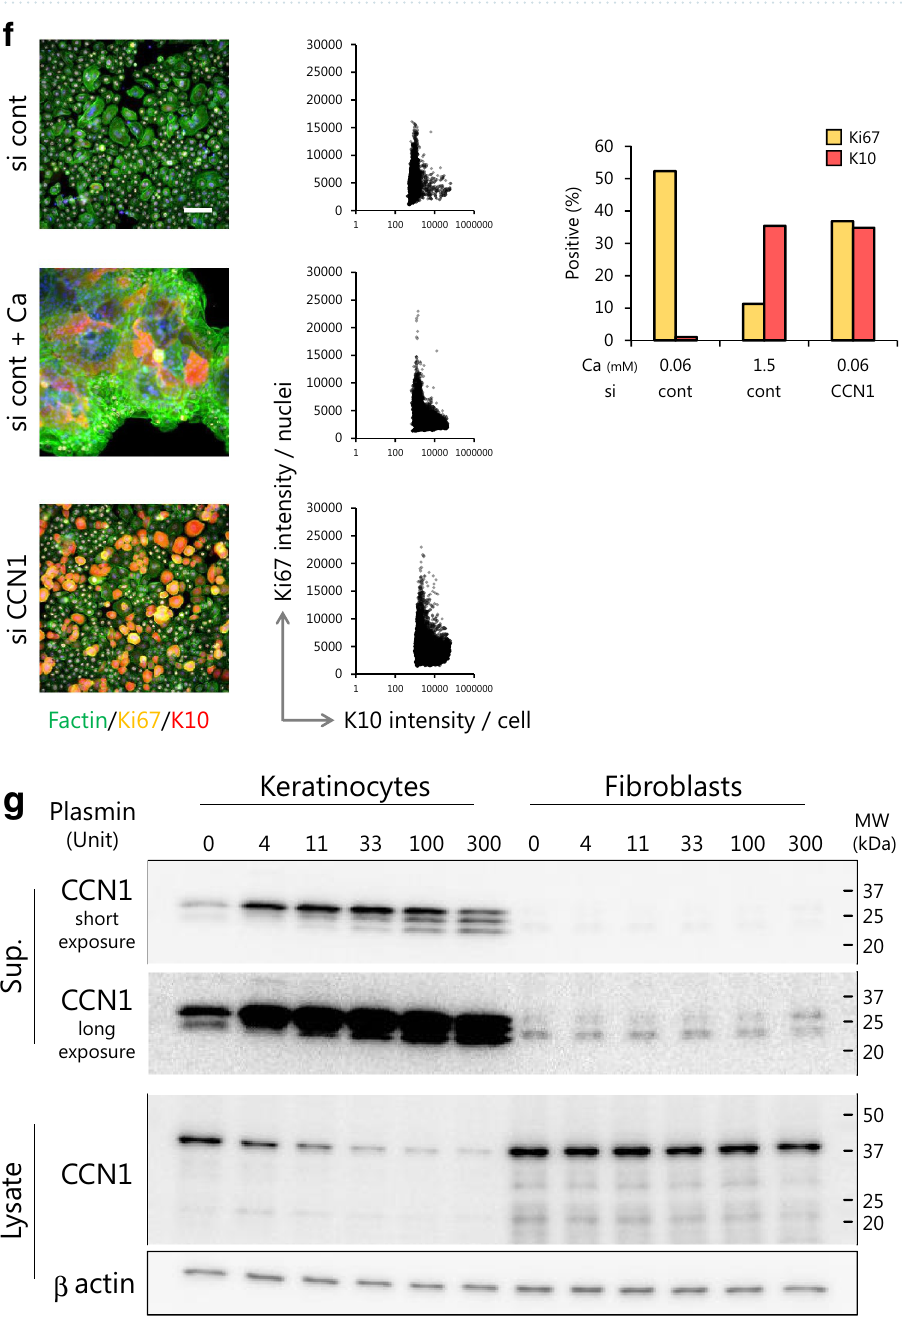
Figure 2. Epidermal CCN1 regulates the balance of growth and differentiation of normal human keratinocytes. CCN1 localization examined by immunohistochemistry (IHC) and by in situ hybridization (ISH) in human skin. Bars = 100 μm ( a ). Overview of the experimental method for the siRNA-transfected 3D epidermal model ( b ). Knockdown efficacy of CCN1 on day 4 determined by Western Blots of HPEKp supernatant samples. Full- length gels and blots are included in Supplemental Fig. 6a ( c ). Apical view of reconstructed skin before (day 4) and after (day 10) induction of differentiation, Bar = 300 μm (left). HE staining of reconstructed epidermis section, Bar = 20 μm (right) ( d ). Effects of CCN1 knockdown on mRNA levels of CCN1, Keratin 10, Aquaporin 3, Transglutaminase 1 and Filaggrin determined by qPCR. Total RNAs were collected from siRNA-transfected keratinocytes 6 h after Ca stimulation. Values reported are means ± SD of n = 3 replicates, Tukey’s test, * p < 0.05, ** p < 0.01, *** p < 0.001 ( e ). Effects of CCN1 knockdown on Ki67 and K10 expression determined by imaging cytometry. Keratinocytes were fixed 48 h after transfection, Bar = 100 μm, n = 10,000 cells ( f ). Comparison of reactivity to plasmin treatment between keratinocytes and fibroblasts. Secreted (short and long exposure times) and cellular CCN1 levels were determined by Western Blots. Samples were collected 24 h after plasmin treatment. Full-length gels and blots are included in Supplemental Fig. 6b ( g